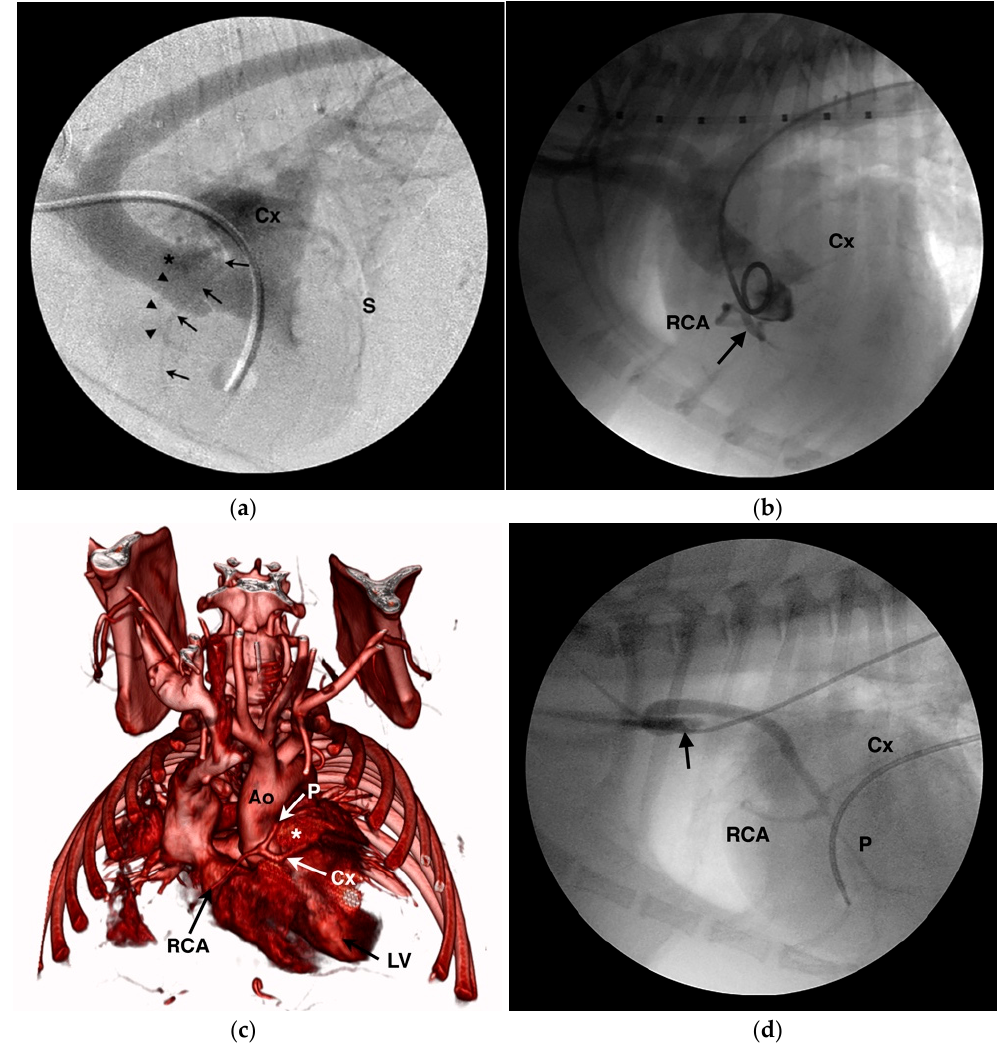
Figure 5. Angiograms of unique coronary artery anomalies in 4 dogs. ( a ) Levophase from a digitally-subtracted right ventriculogram in an English bulldog with pulmonary valve stenosis showing a single left coronary ostium (*) that gives a short left main coronary artery before branching into the paraconal interventricular (arrowheads), circumflex (Cx), and subsinuosal interventricular (S) branches. There is no right coronary ostium and the right coronary artery (arrows) can be seen arising from either the left main or circumflex branch. ( b ) Aortic root angiogram from an English bulldog with a single right coronary ostium that gives the right coronary artery (RCA) as well as a short left main coronary artery (arrow) that passes between the aortic root and right ventricular outflow tract before giving off the circumflex branch (Cx) and small septal or paraconal branches. ( c ) 3-dimensional, volume-rendered reformat of a computed tomography angiogram from an English bulldog with a single right coronary ostium from which arises the right coronary artery (RCA), absence of the left coronary artery, a prepulmonary course for the paraconal interventricular branch (P), and an interarterial course for the circumflex branch (Cx). A portion of the right ventricular outflow tract has been digitally removed to show the left coronary branches encircling the pulmonary trunk (*). LV = left ventricle, Ao = aorta. ( d ) Selective arteriogram from a mixed breed dog with tetralogy of Fallot whose entire coronary circulation arises off the brachiocephalic trunk (arrow), traverses lateral to the ascending aorta, and then trifurcates caudal to the aortic root into the right coronary artery (RCA) and the paraconal interventricular (P), circumflex (Cx), and subsinuosal interventricular branches.